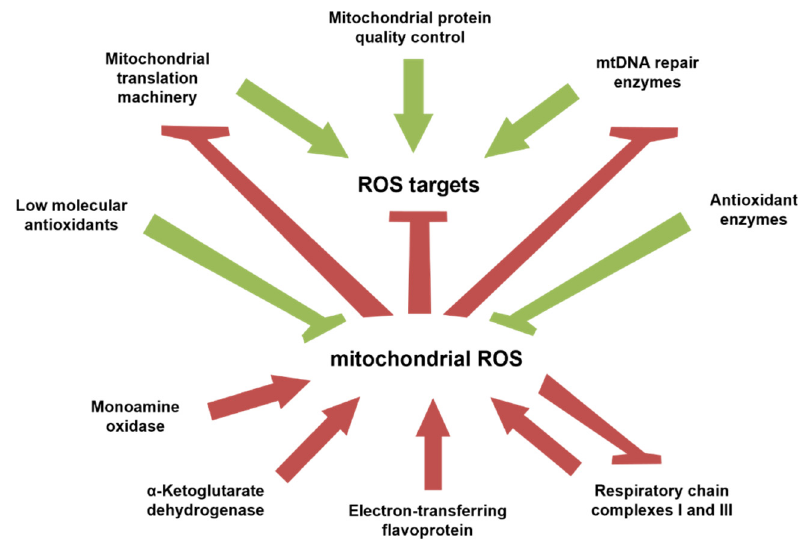
Figure 4. Relationship between pro- and antiaging processes and mitochondrially produced ROS that may account for the rapid decline of mitochondrial function in the second half of life. Red activation and inhibition arrows denote pro-aging players, whereas green activation and inhibition arrows denote antiaging players.